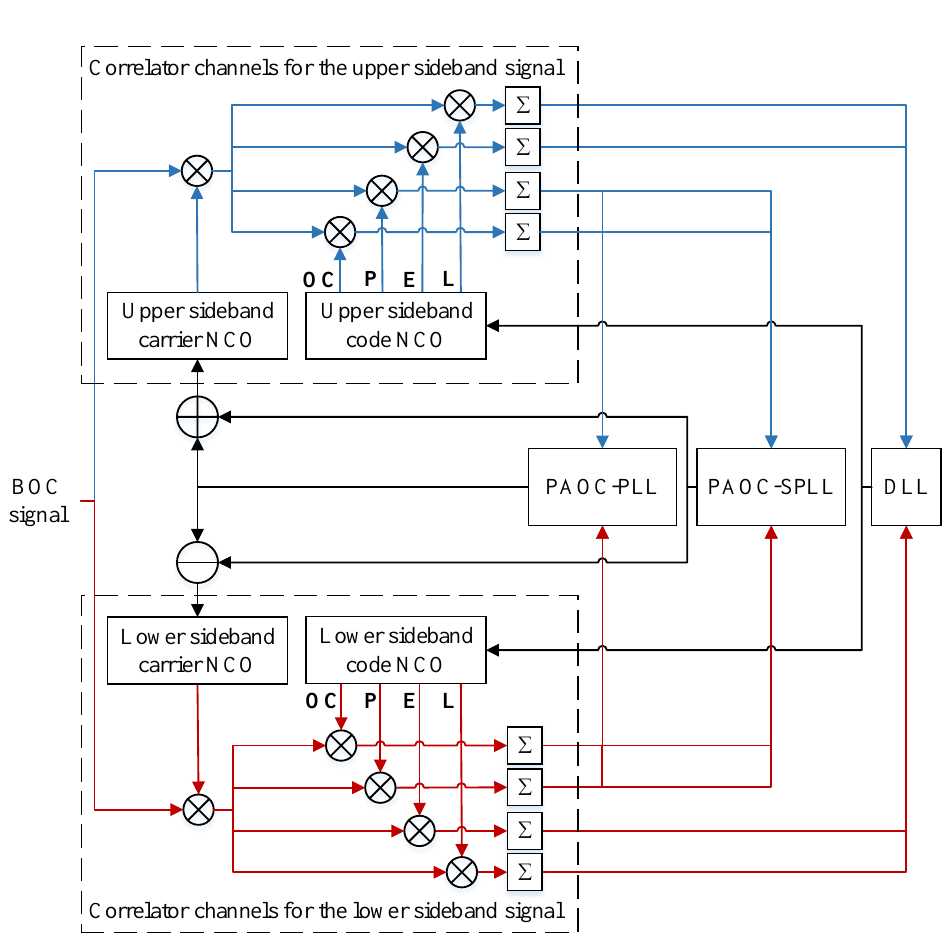
Figure 6. Implementation architecture of the PAOC technique in the DBT loop for BOC